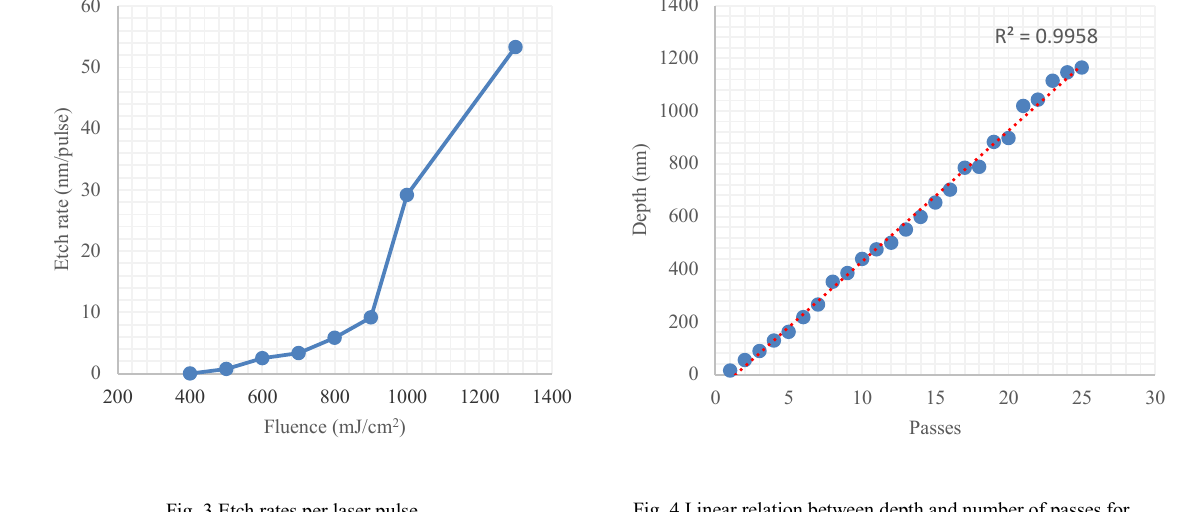
fluence 800 mJ/cm 2 .